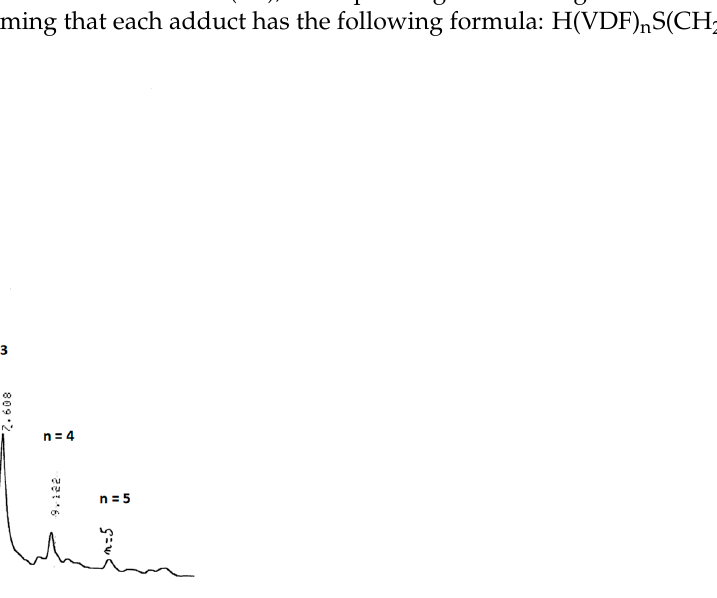
Figure 3. GC chromatogram of acetylated telomers mixture obtained from the telomerisation of VDF with 2-mercaptoethanol (initiated by di- tert -butyl peroxide, R 0 = [CTA] 0 /[VDF] 0 = 0.1, in acetonitrile as the solvent, at 140 °C, 5 h).